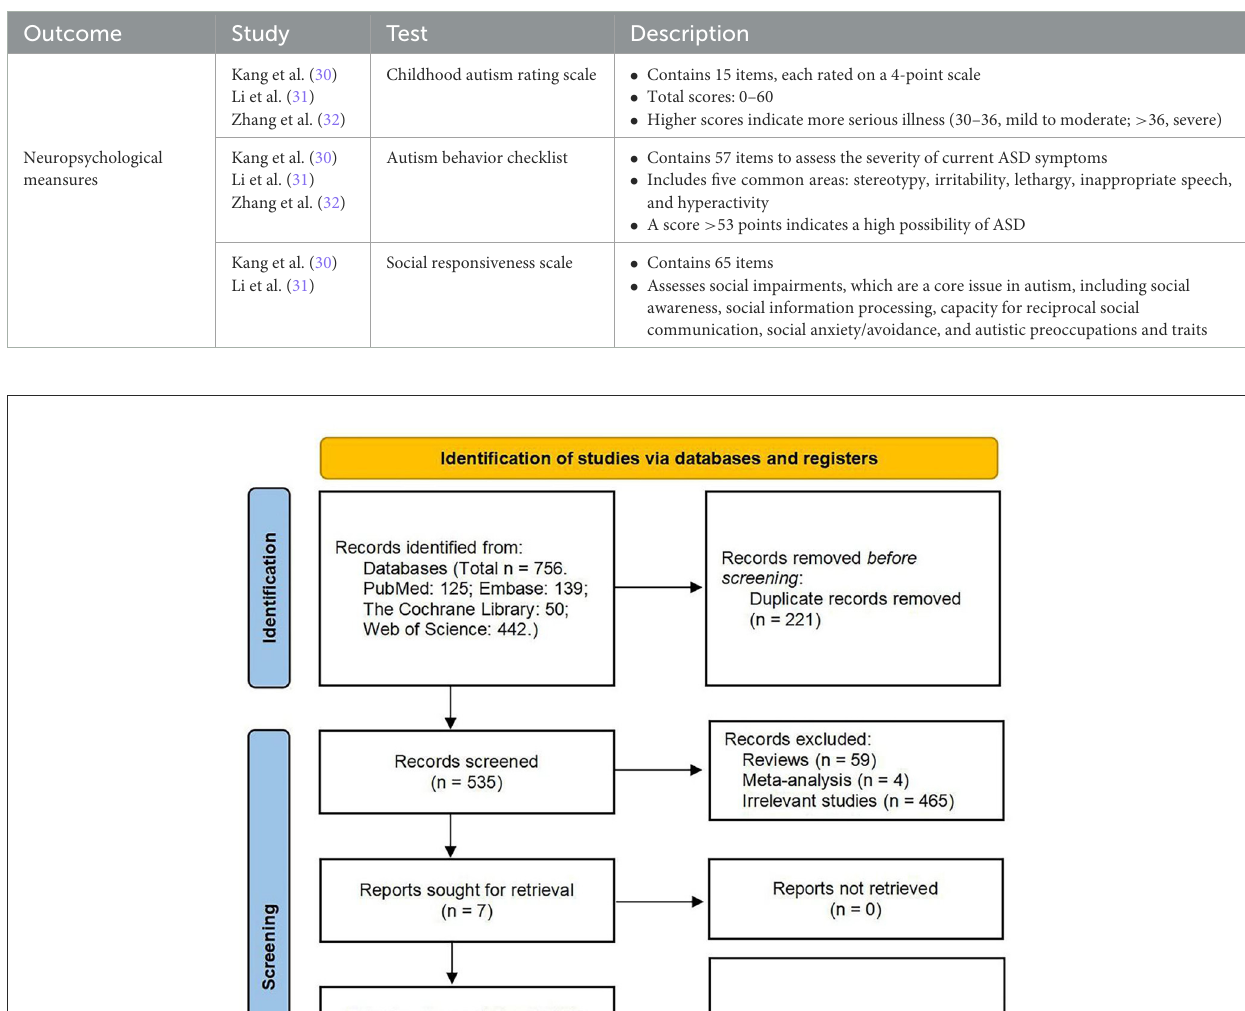
high-dose SHGM regimen comprised a daily dosage of 2.5 × 10 12 cells, with 2 days of oral and 1 day of rectal SHGM